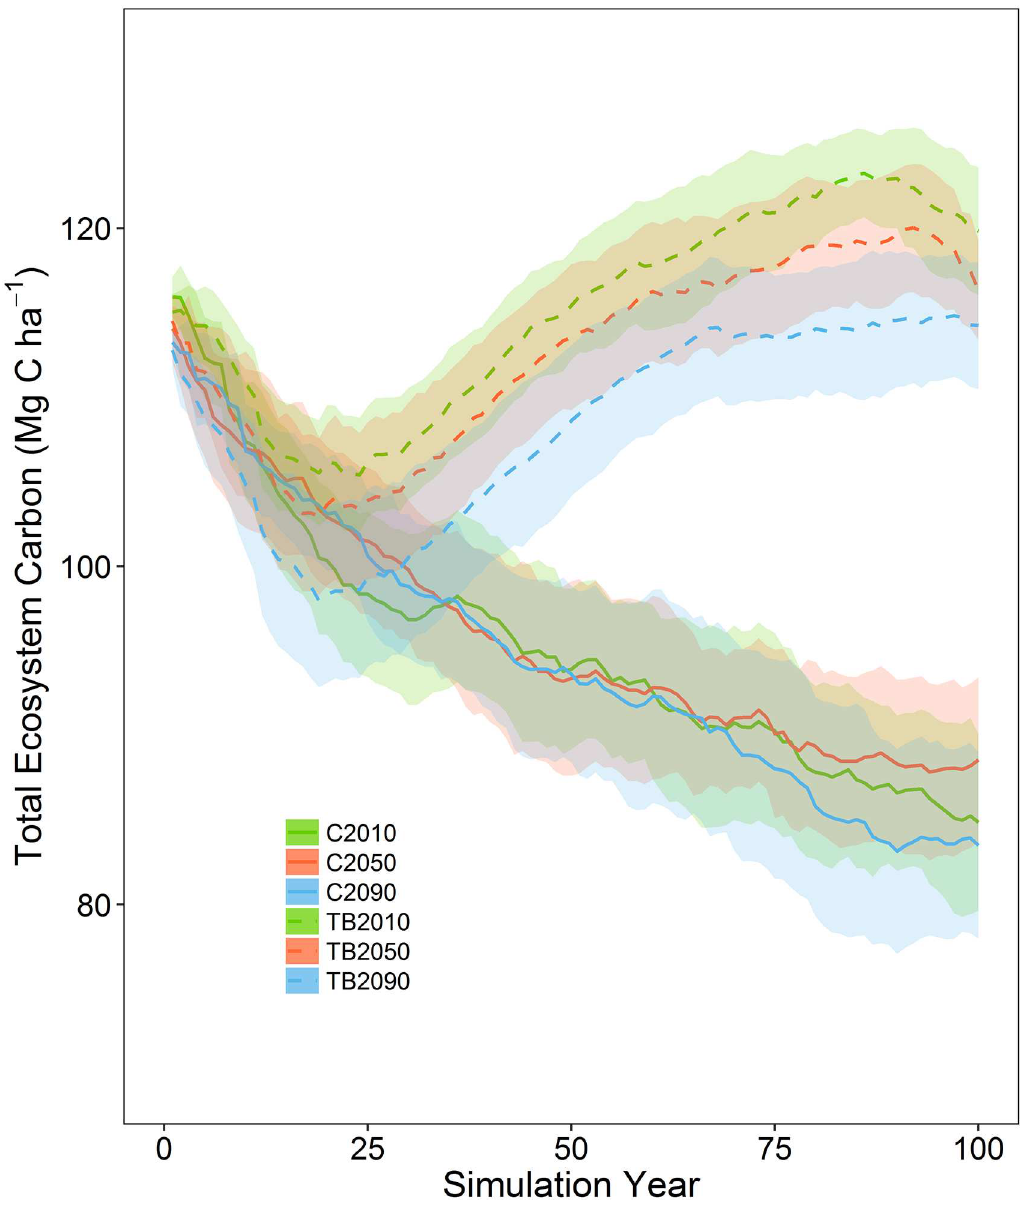
Fig 2. Mean total ecosystem carbon for two simulated treatments (control (C), thin and burn (TB)) under three different climate periods (2010–2019, 2050–2059, 2090–2099)with the same wildfire parameterization over the 100-yearsimulation period. Shadedareas are the 95%